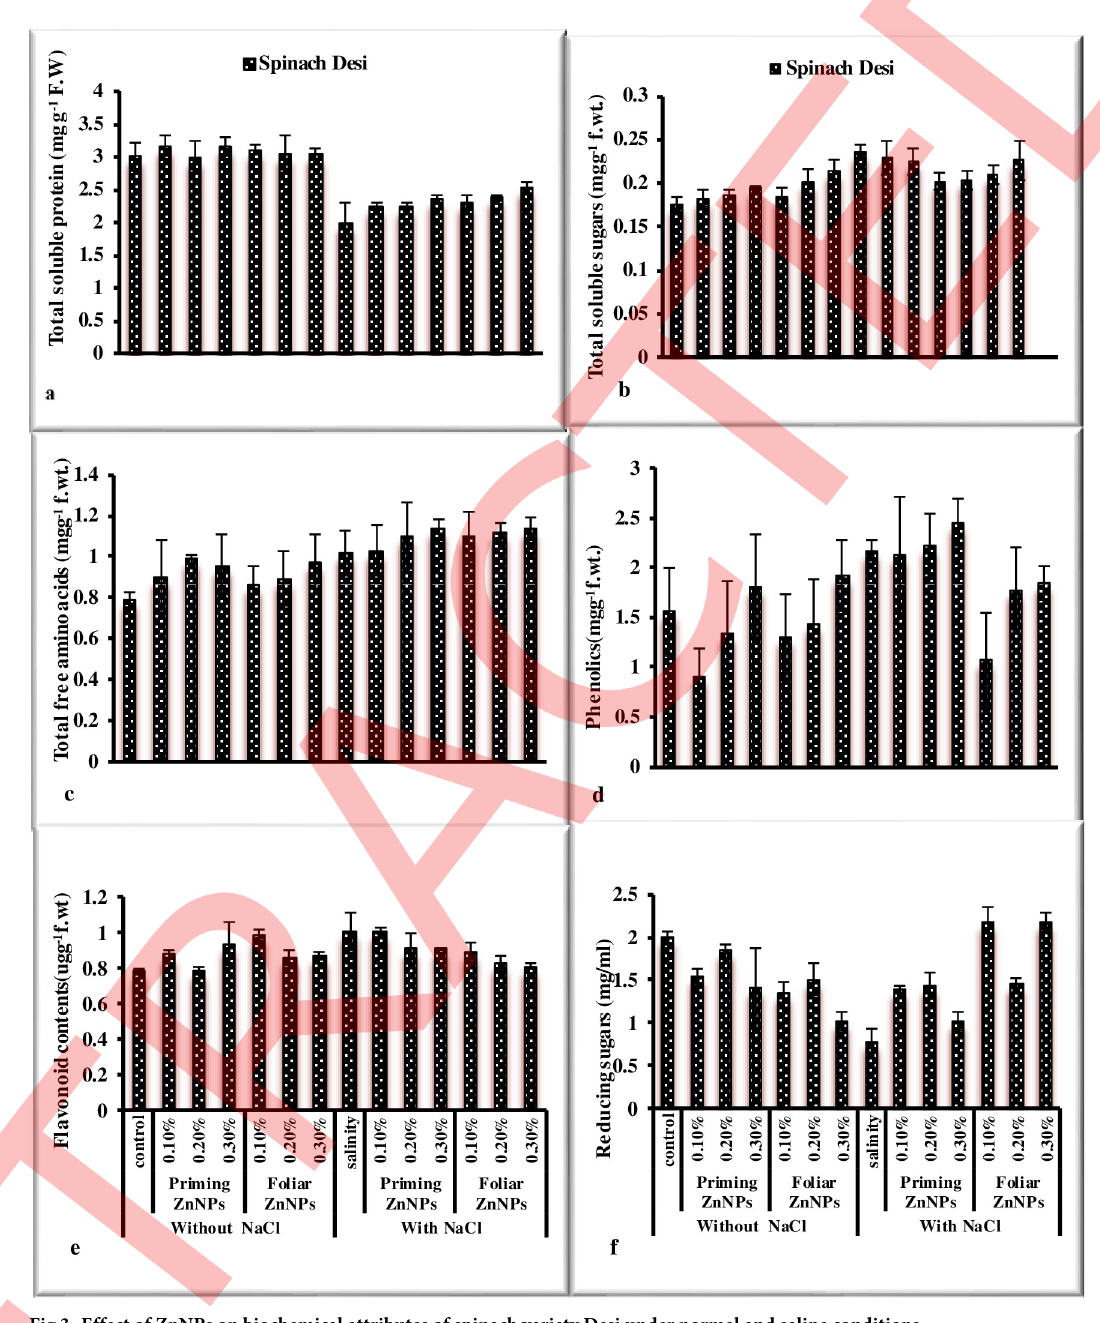
Fig 3. Effect of ZnNPs on biochemical attributes of spinach variety Desi under normal and saline conditions. recorded highest at 0.1% foliar treatment of ZnNPs as stated by Sun et al. [42]. The decrease in photosynthetic pigment under salinity stress is also associated with the oxidation of chloro- phyll contents through free radicals, interference of salt ions and pigment-protein complexes, chloroplasts disruption or enhancement in the values of chlorophyllase for the breakdown of chlorophyll [43, 44] as reported in A . hybridus . Shahbaz et al. [45] stated a stress-related decrease in Chl contents in wheat. In plants, the chlorophyll content amount is the main